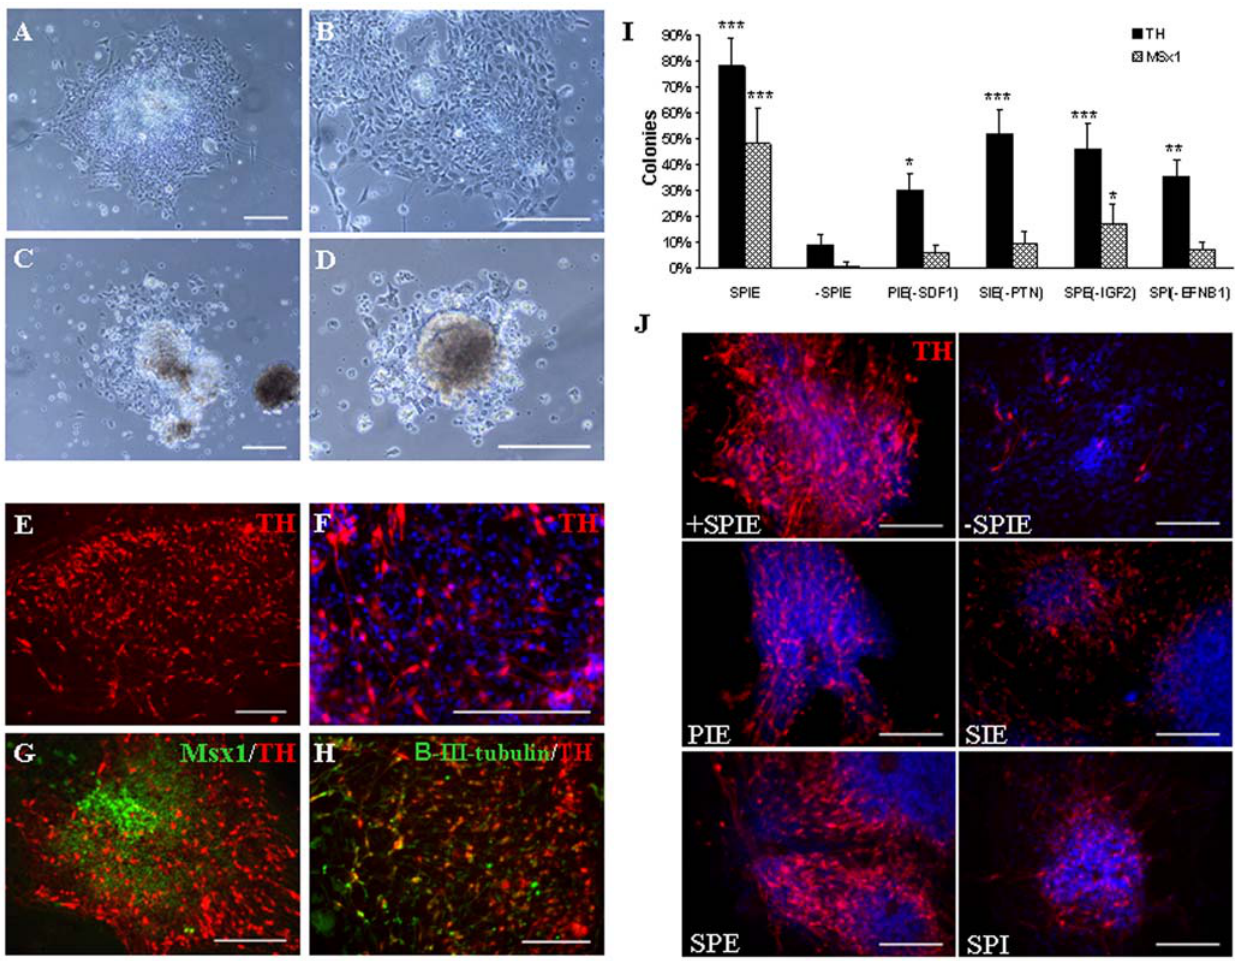
Figure 3. Differentiation of EBs into TH + neurons induced by candidate molecules. Following EB formation, the hESC were transferred to poly-L-ornithine/laminin coated dishes and treated with SDF-1, IGF2, IGFBP4, PTN, EFNB1, and heparin. After three days, EBs attached to the plates and differentiated into neuroectodermal cells arranged in rosette-like structures with neuronal morphology (A, B). In contrast, the majority of EBs cultured in medium containing heparin in the absence of these molecules did not adhere. The few colonies that did attach in this condition exhibited exceedingly poor cell survival (C, D). After an additional seven days, the majority of colonies contained high percentages of TH + neurons (E, F), although the center of colonies remained in a relatively undifferentiated state with expression of Msx1 (G). b -III-tubulin and TH co-labeling also revealed TH expression in the majority of neuronal cells (H). Scale bars=200 m m. (I) Percentages of colonies expressing TH and Msx1 after 10 days under the influence of various combinations of the four factors, SDF-1(S), PTN (P), IGF2 (I), and EFNB1 (E). For numbers of TH-expressing colonies, each of the various combinations of three of the four factors was significantly different from both SPIE-treated and untreated cultures (all p , 0.001 except untreated vs. SDF1 which was p , 0.05 and SPIE vs. PTN which was p , 0.01). Each of the combinations of three factors produced significantly fewer Msx1-positive colonies than did treatment with complete SPIE (all p , 0.001). The percentage of Msx1-expressing colonies was significantly greater than the untreated condition only for the treatment with all four factors (SPIE) and for the condition excluding IGF2. *=P , 0.05, **=P , 0.01, and ***=P , 0.001 as compared to the untreated condition (Tukey-Kramer multiple comparisons following one-way analysis of variance). (J) Examples of colonies with omission of each individual factor, illustrating that fewer TH + cells were detected within colonies, although numbers of TH + cells within colonies could not be quantified.